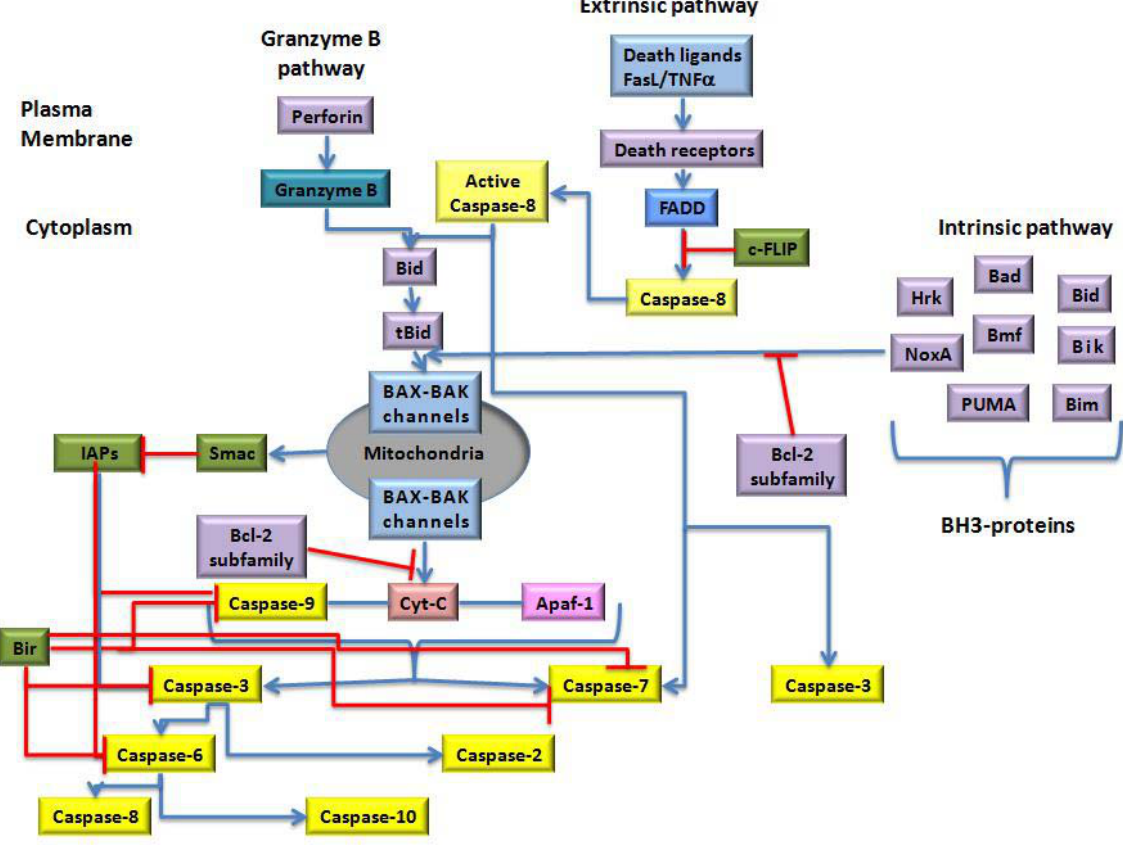
Figure 3: In this figure three activation pathways of caspases are shown: intrinsic (right), controlled by members of the family of Bcl-2 proteins; extrinsic (middle) activated by the members of the receptor family of Tumor Necrosis Factor; and left, granzyme serine protease family members, which are released by cytoplasmic granules of immune system cytotoxic T cells and natural killer cells. These three pathways lead to mitochondria, and after mitochondrial activation results in the release of proteins, there is normally no return, because caspases pathway